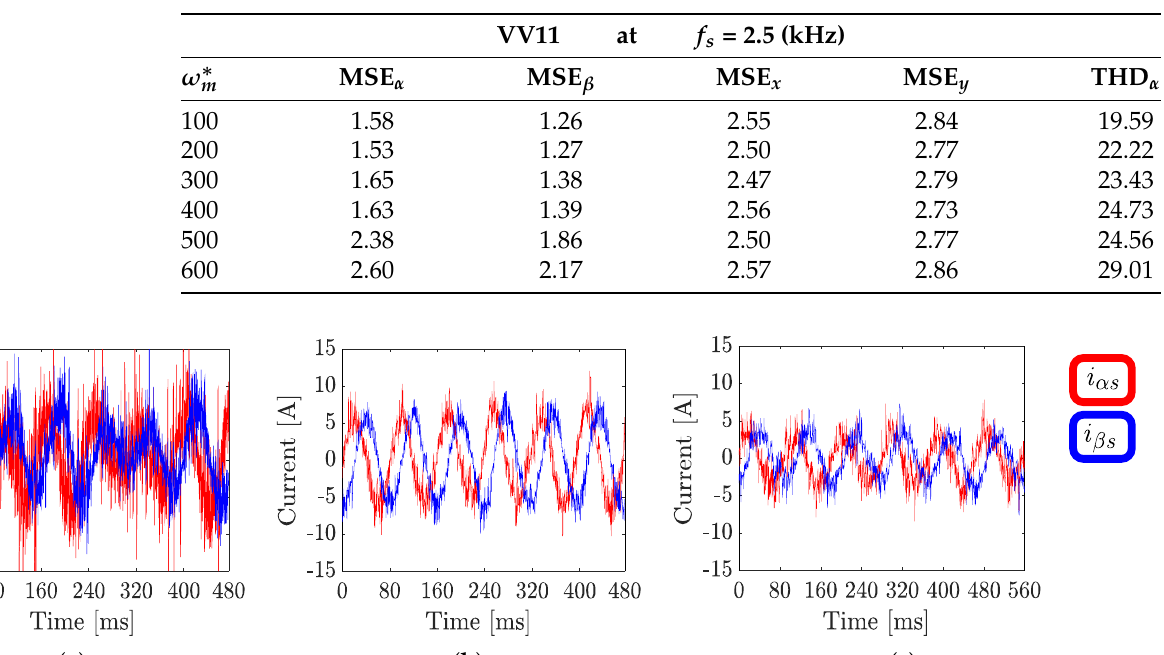
Table 3. Performance indicators for the drive operating from 100 [rpm] to 600 [rpm] for VV11.